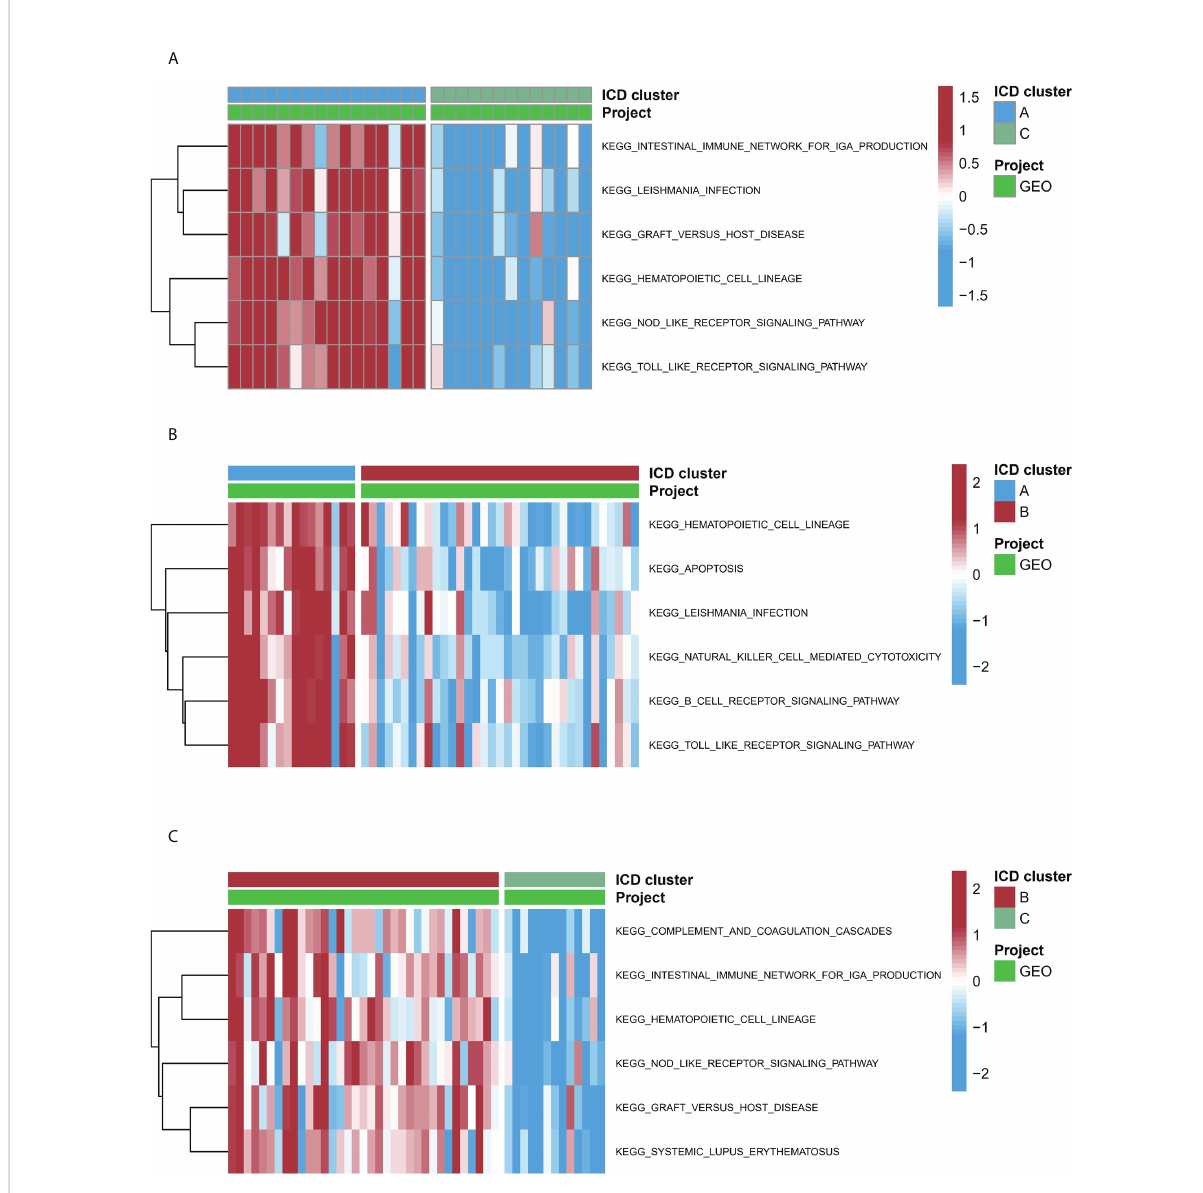
FIGURE 7 The underlying biological function characteristics diversity across three ICD patterns. (A) The variations in KEGG pathway enrichment scores across ICD patterns A and C. (B) The variations in KEGG pathway enrichment scores across ICD patterns A and B. (C) The variations in KEGG pathway enrichment scores across ICD patterns B and